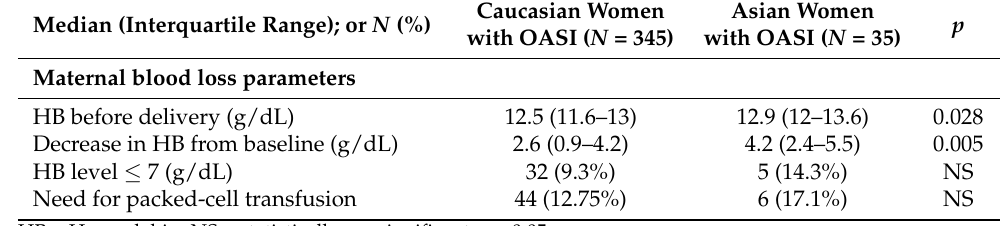
Table 2. Differences in OASI-related blood loss complications among Caucasian women and women of Asian ethnicity.